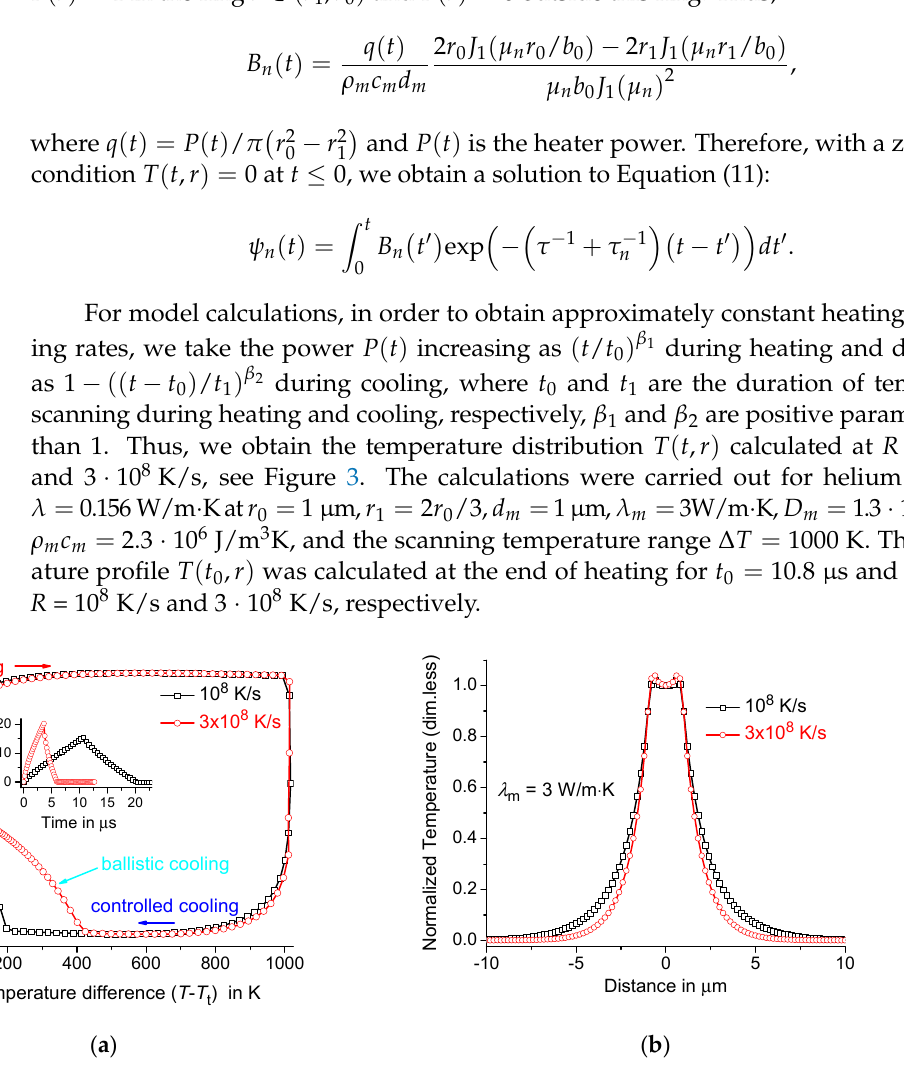
Figure 3. Normalized scanning rate ∂ T / ∂ t vs. temperature at the center of the membrane for the power P ( t ) shown in the inset ( a ) and the temperature profile T ( t 0 , r ) ( b ) for R = 10 8 K/s and 3 · 10 8 K/s—black squares and red circles, respectively. The heater acts uniformly in the ring r ∈ ( r 1 , r 0 ) at r 1 = 2 r 0 /3. Thermal conductivity of the membrane λ m = 3 W/m·K.